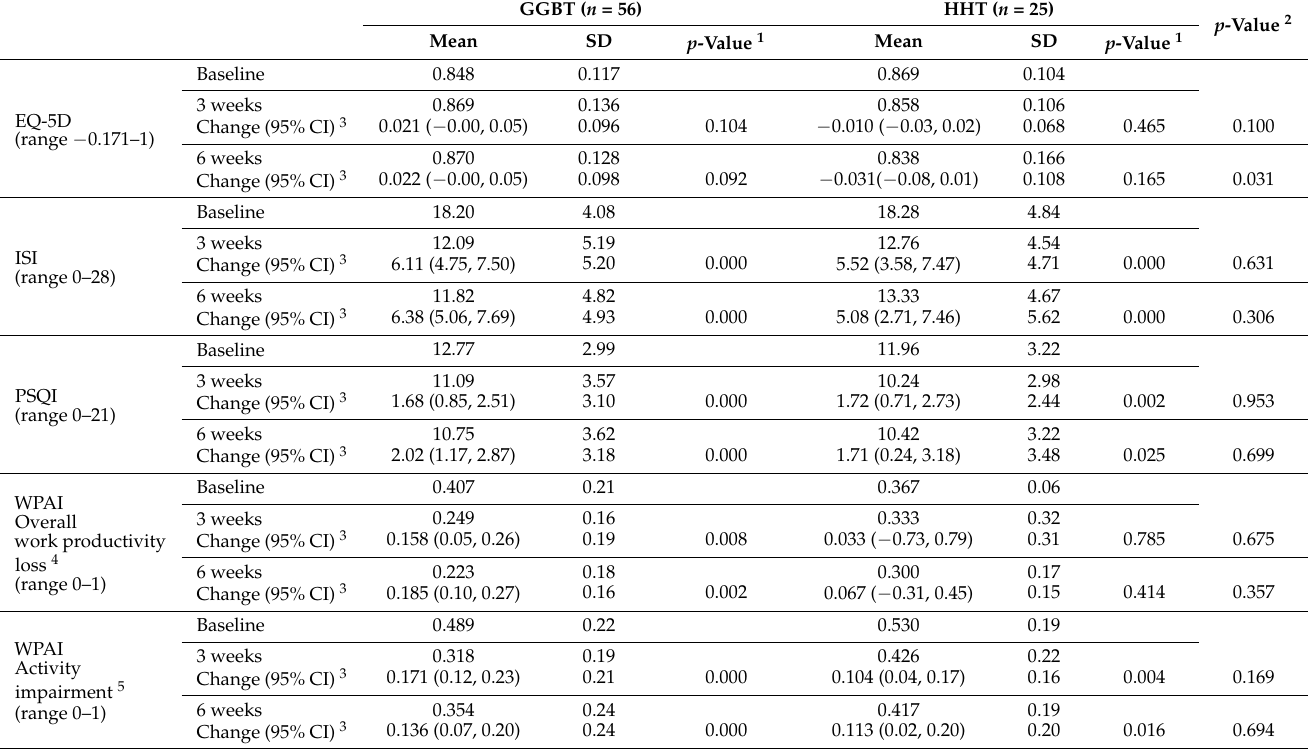
Table 2. Treatment outcomes within the group during follow-up and between groups (per protocol).